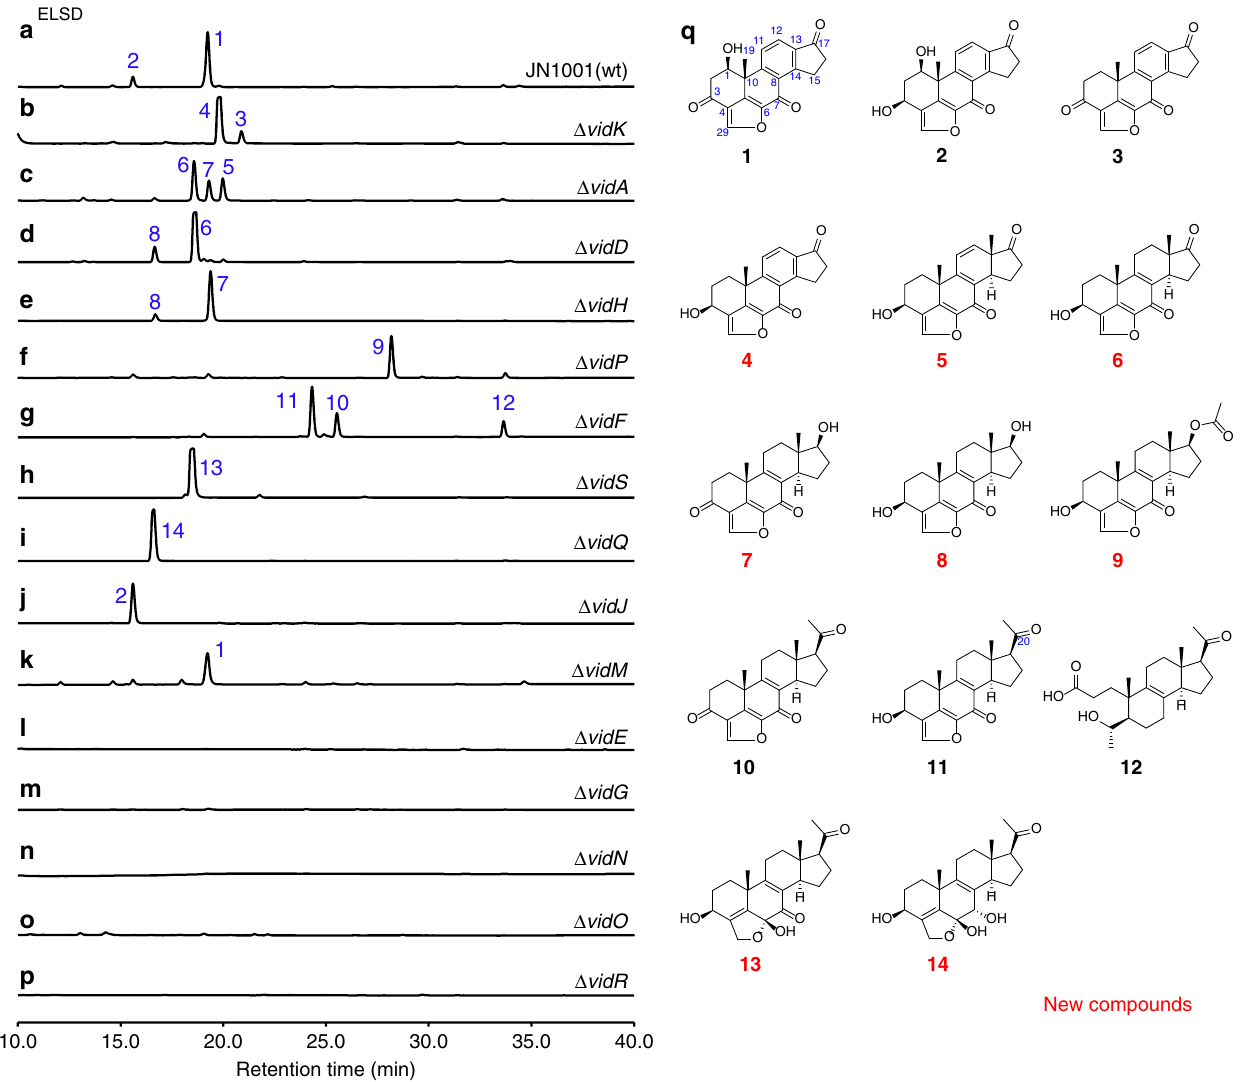
Fig. 2 Metabolite analysis of the vid gene deletion mutants. a – p HPLC pro fi les of extracts from the vid gene deletion mutants. q Structures of the compounds isolated from the vid gene deletion mutants. The chromatograms were monitored with an evaporative light scattering detector (ELSD). The new compounds are indicated by red